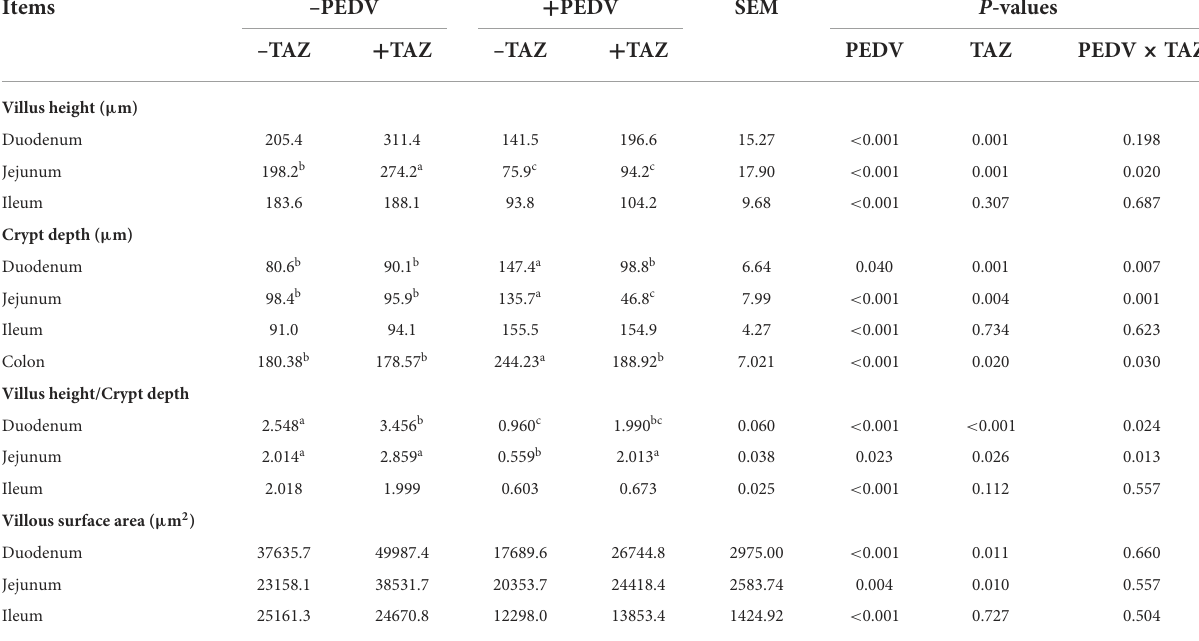
TABLE 6 The effect of tannic acid-chelated zinc on the intestinal morphology in PEDV-infected piglets.